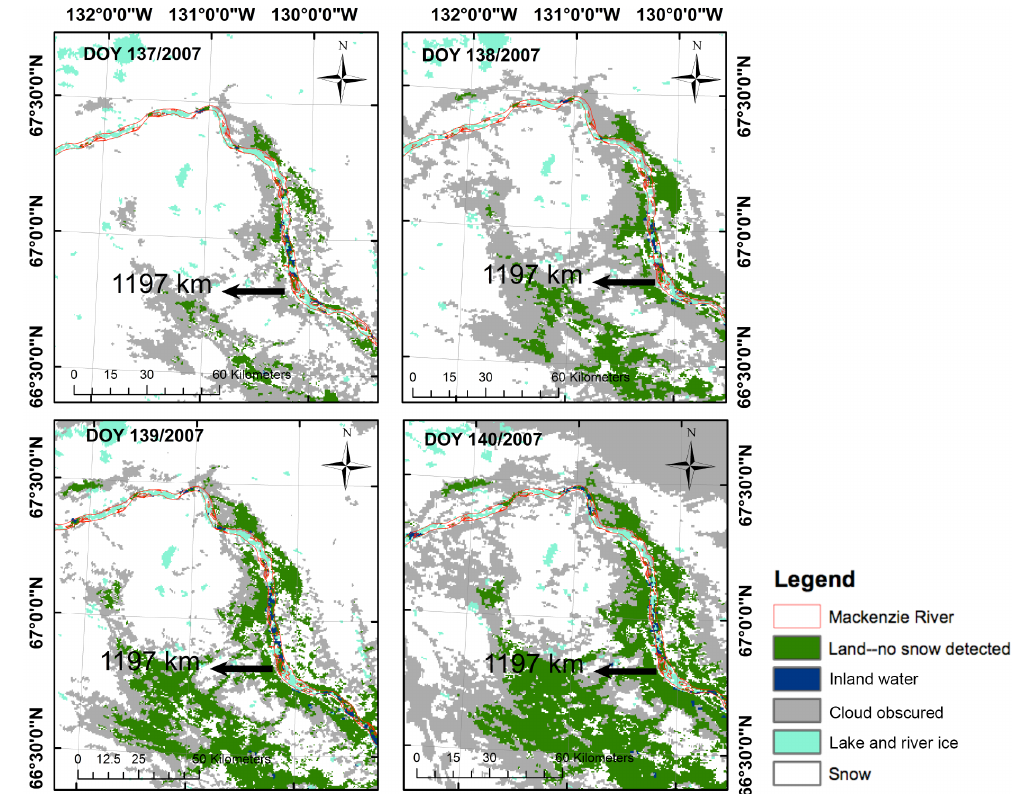
Figure 12. Observation of dynamic break-up over a section of the Mackenzie River basin, showing concurrent ice break-up and snowmelt over 6 days. This was observed in 2007 between DOYs 137 and